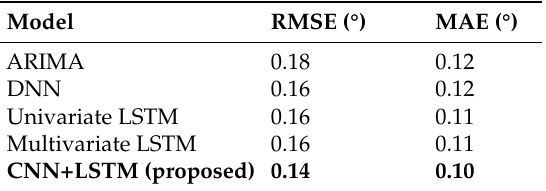
Figure 8. The prediction results of “JingHai-III” by the proposed model: ( a ) test set-1; ( b ) test set-2; and ( c ) test set-3. Table 7. RMSEs and MAEs of each model in “JingHai-III” test set-1.